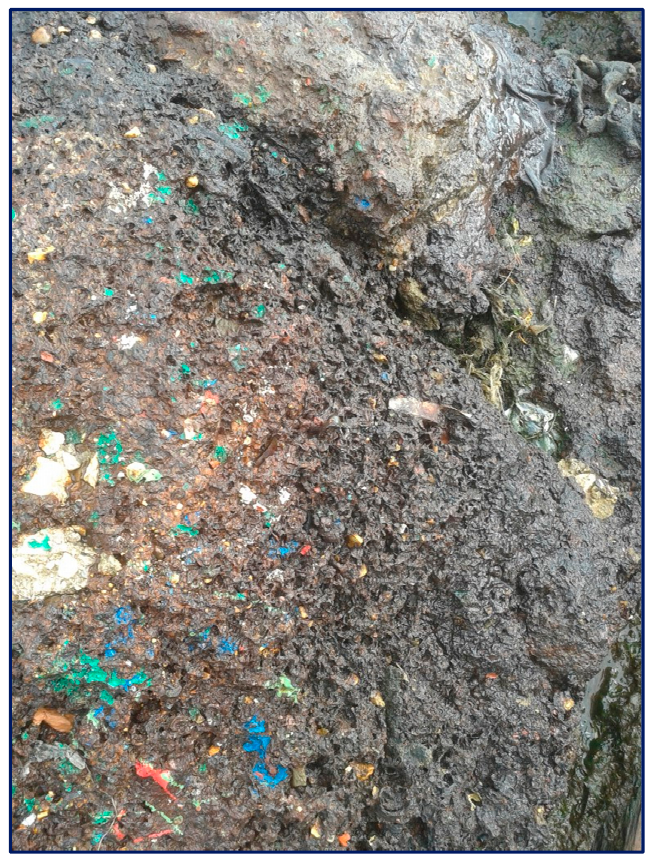
Figure 2. Layering of plastic materials in an area of Southern Italy.